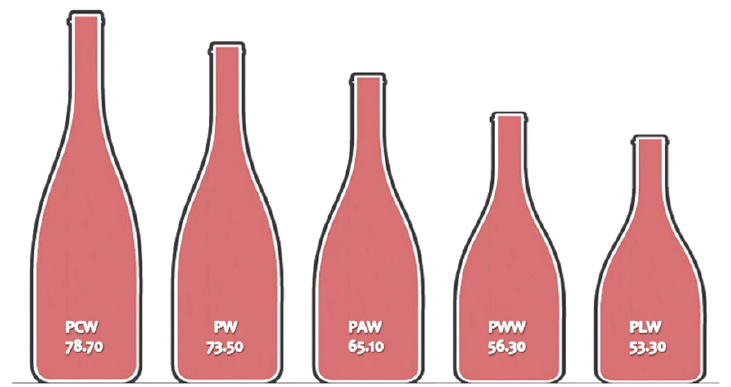
Figure 3. Overall grades of sensory characteristics of ‘Prokupac’ wines (on a 100-point scale).